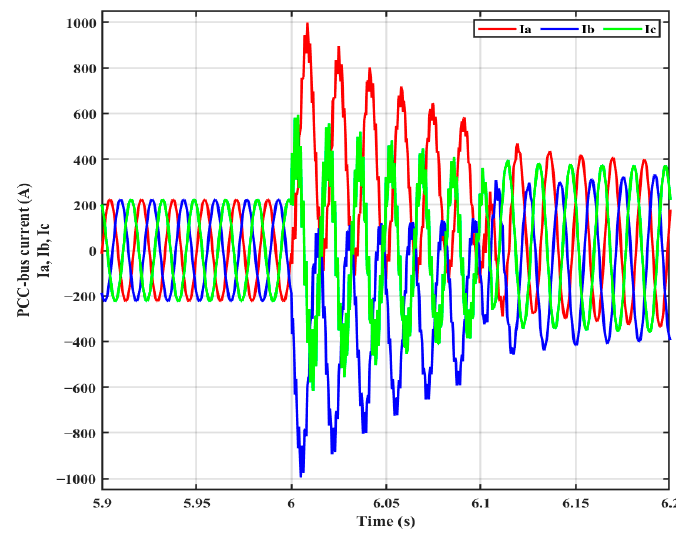
Figure 26. Current of PCC bus with LLLG fault.